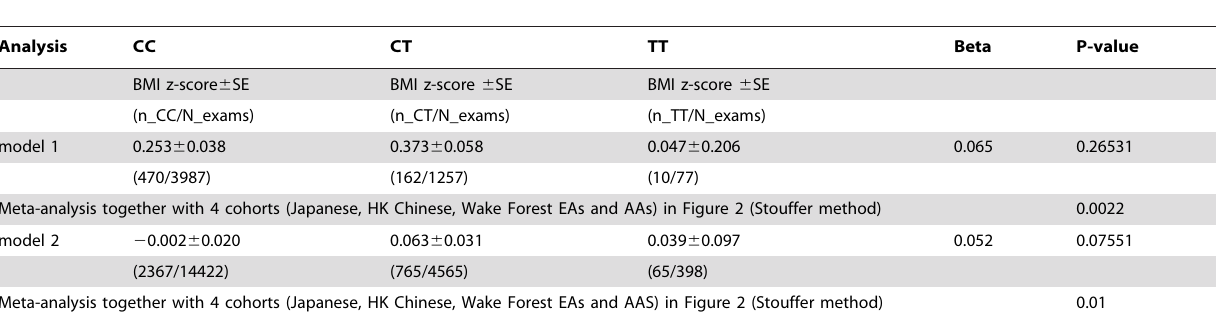
Table 2. Association of rs2268388(C/T) with BMI in full-heritage Pima Indian longitudinal cohort.